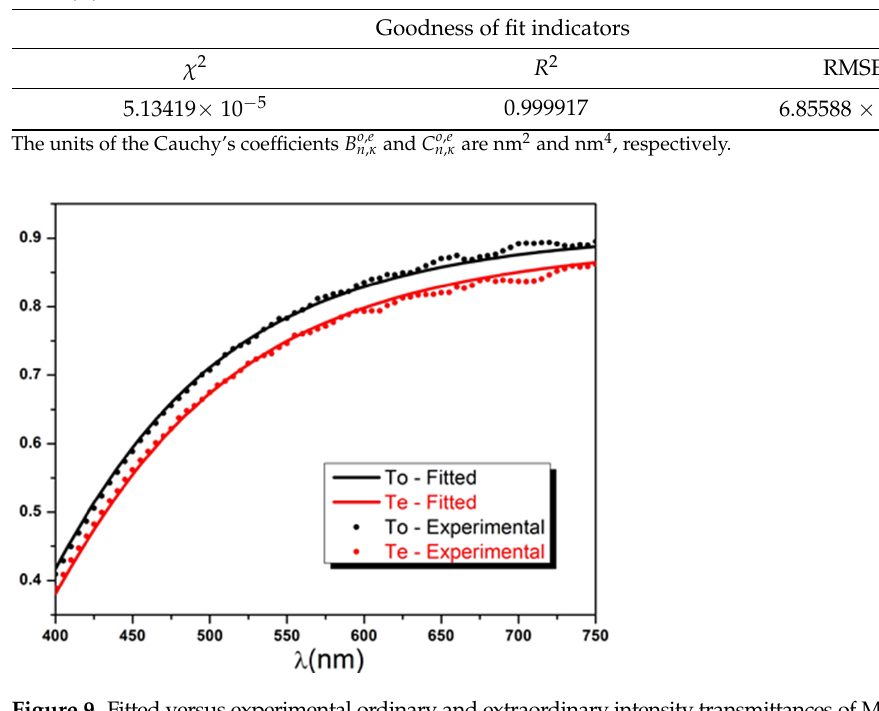
Figure 9. Fitted versus experimental ordinary and extraordinary intensity transmittances of Mylar sample.